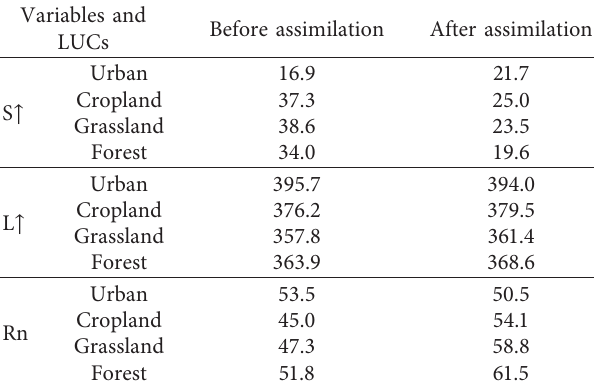
Table 4: Simulated annual average upward solar radiation, upward longwave radiation, and net radiation for urban, cropland, grassland, and forest LUCs before and after